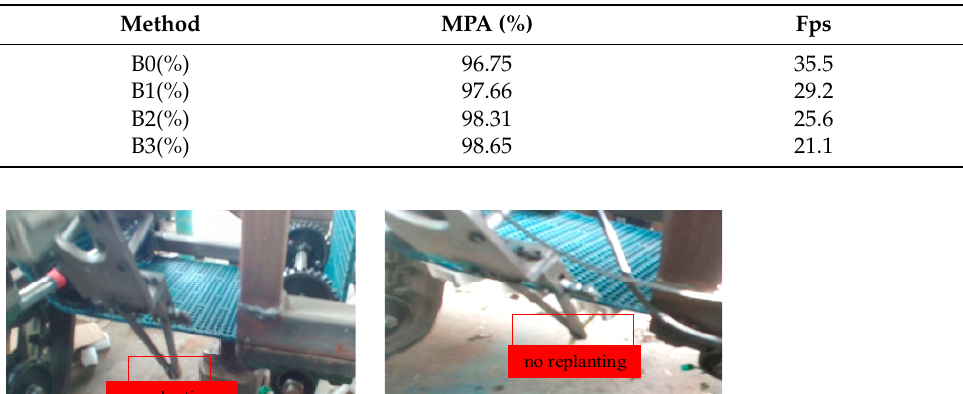
Table 3. Sweet potato seedlings detection result.